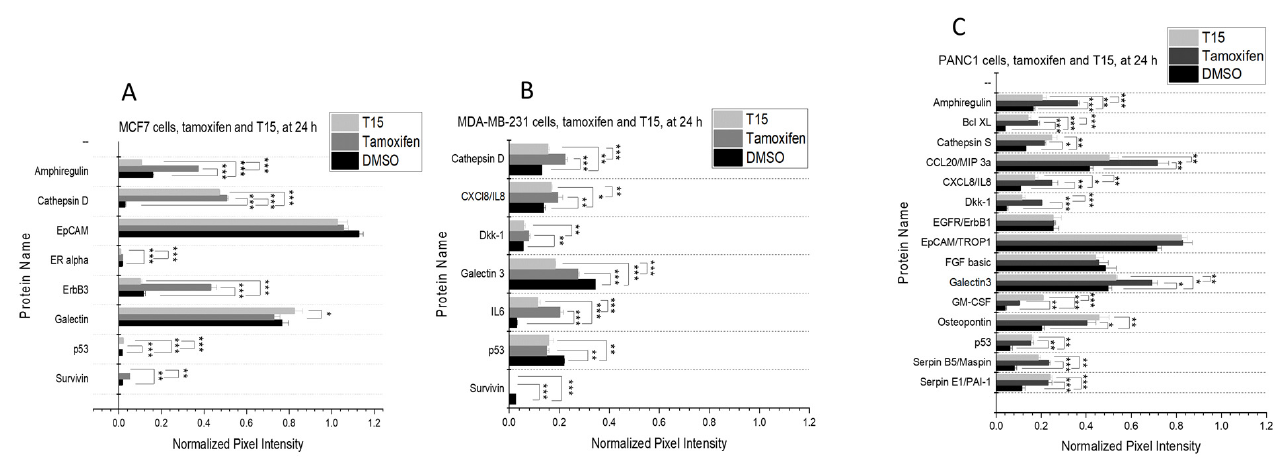
Figure 4. Protein expression changes of MCF7 ( A ), MDA-MB-231 ( B ), and PANC1 ( C ) cells after 24 h following treatment with tamoxifen and T15. Pictures of the original membranes ( A ) were taken after 10 min of exposition. Each protein pair, where at least one of the samples showed 20% of the pixel intensity of the reference points, were annotated then graphically represented ( B ). During the experiment, two parallel samples were used ( n = 2). Data are given as mean values ± standard deviation (SD). Asterisks mark the significant differences between groups ( p < 0.05: *, p < 0.01: **, p < 0.001: ***) determined by the One-way ANOVA test followed by Fisher’s LSD post hoc